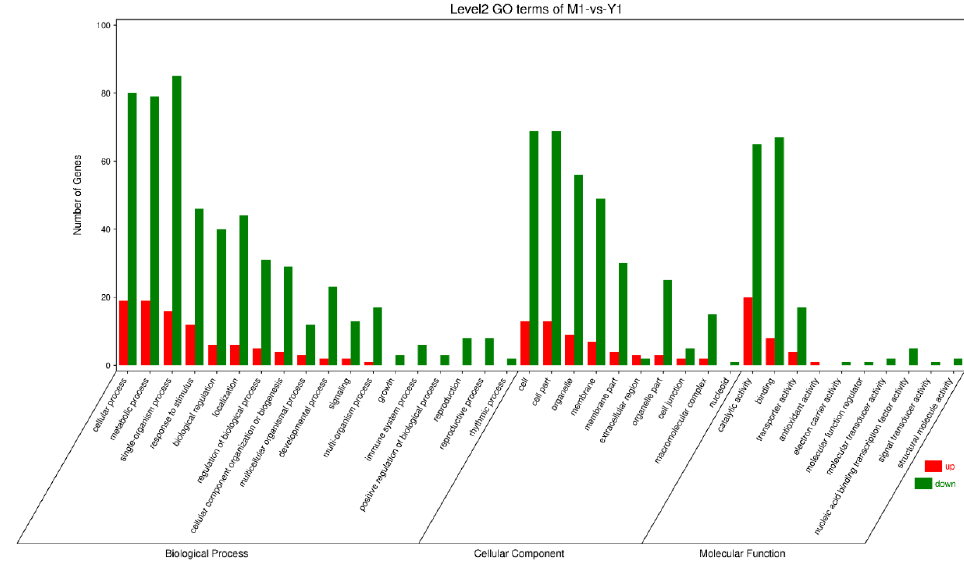
Figure 5. GO enrichment classification map of differentially expressed genes.